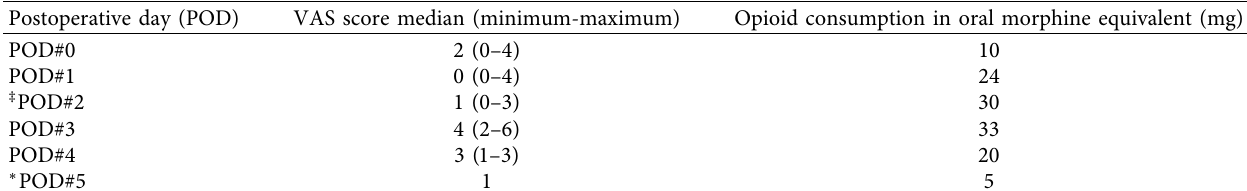
Table 1: Postoperative pain scores (VAS, visual analog score) and opioid consumption in morphine equivalent. Postoperative day (POD)